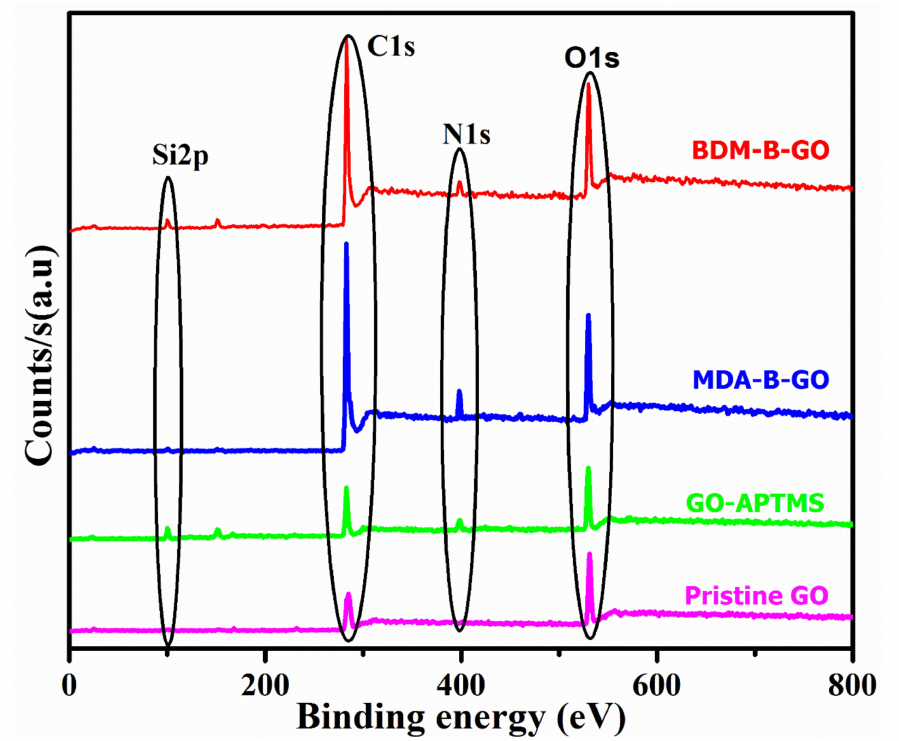
Figure 2. XPS spectra of GO, GO-APTMS, MDA-B-GO and